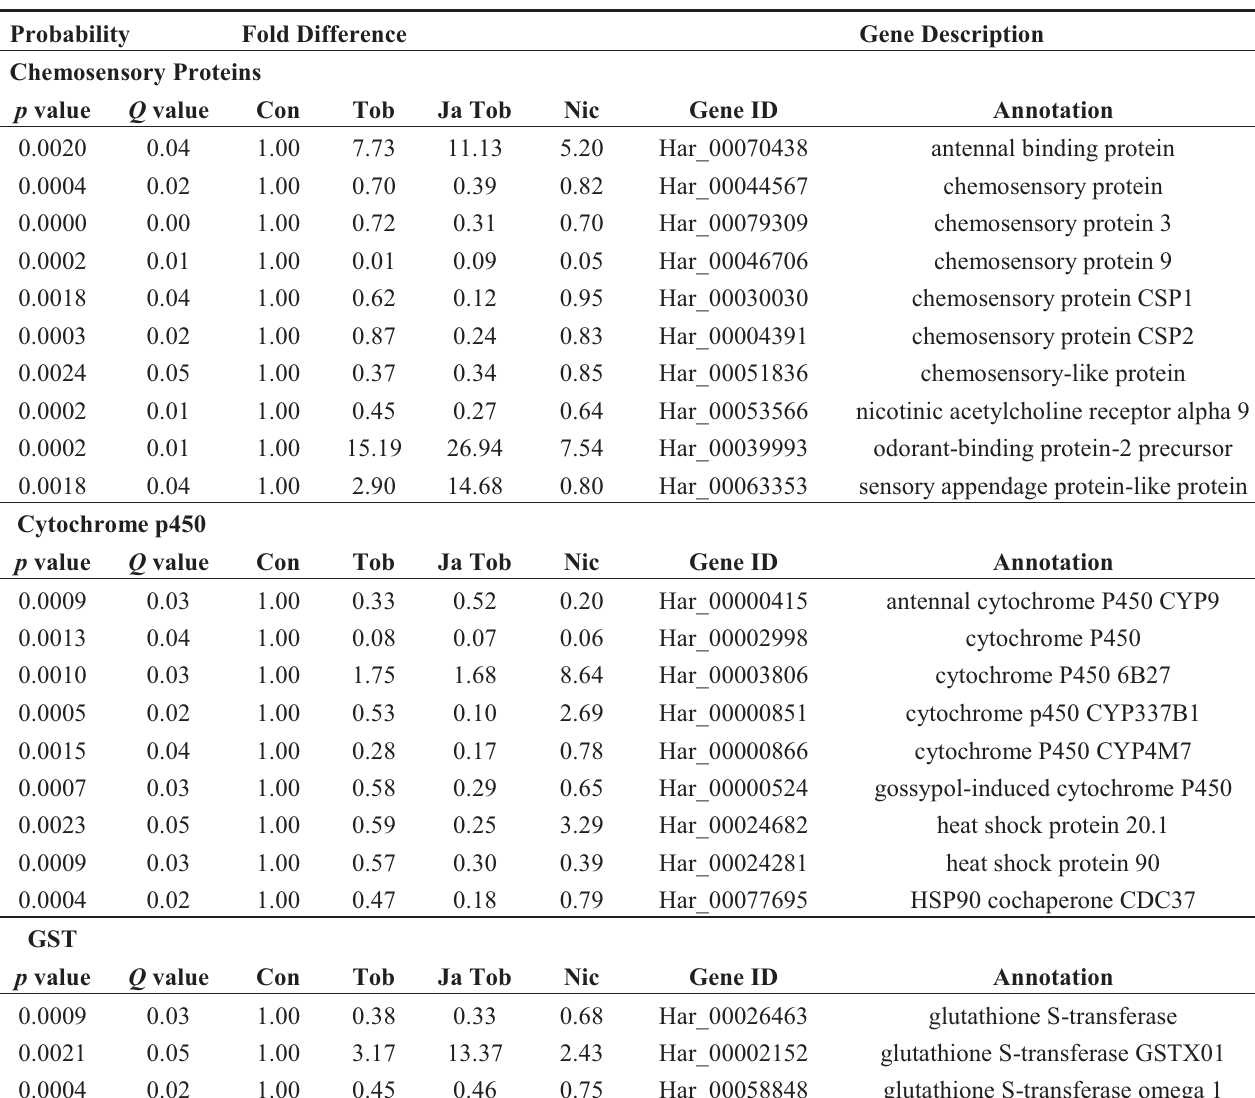
Table 4. Expression of chemosensory proteins, cytochrome p450 and GST related genes. Gene name, fold change and NCBI reference sequence are